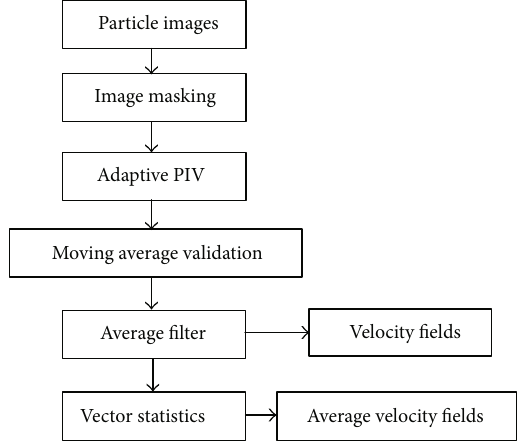
Figure 4: Process for calculating velocity vectors from PIV image. Figure 5: Boundary-layer pro fi le of the blunt-based body. fl ow. The results of boundary-layer pro fi le are presented in Figure 5. Despite the fact that the number of points is lim-